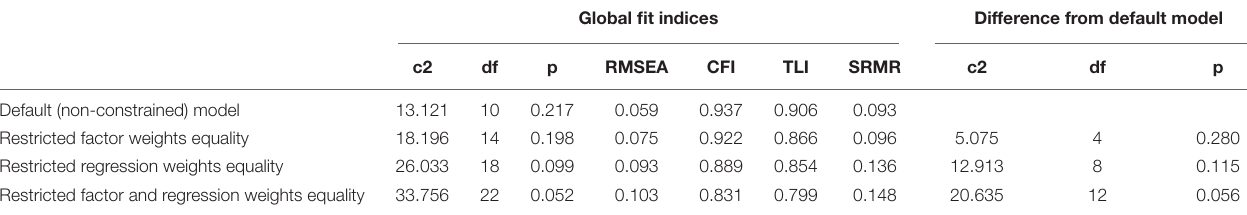
TABLE 4 | Summary of model comparison for tested models with different restrictions